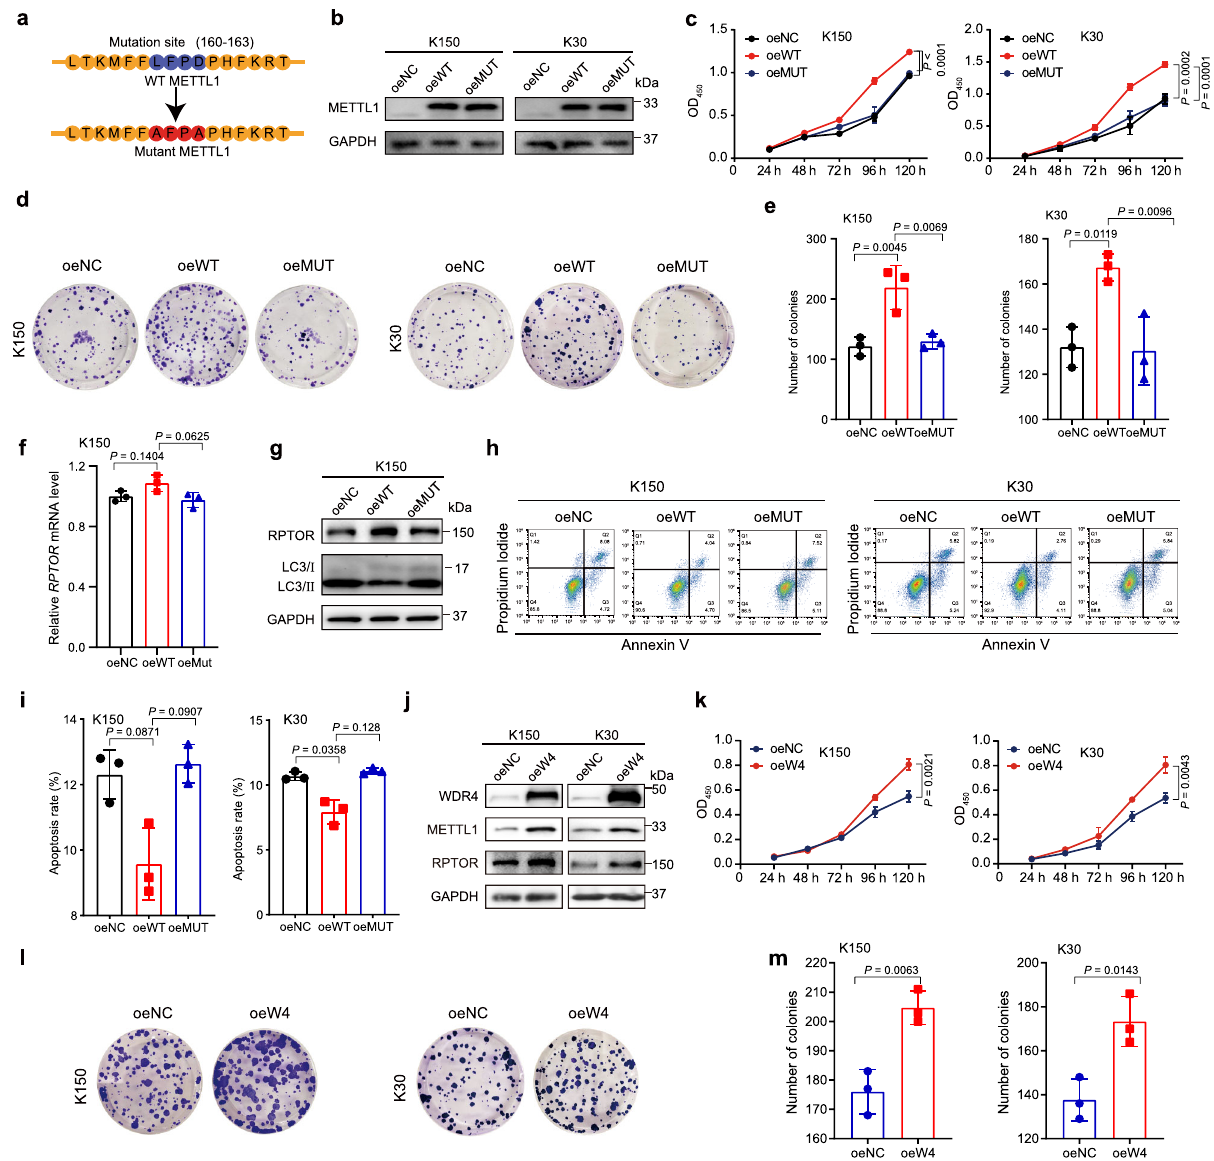
Fig. 6 Overexpression of METTL1 or WDR4 promotes ESCC progression. a The catalytic mutation site of METTL1. b Western blot con fi rmed the overexpression of wild-type METTL1 (oeWT) and catalytic inactive METTL1 (oeMUT) compared with the negative control (oeNC) in ESCC cells. c CCK8 assay of growth of oeNC, oeWT, and oeMUT ESCC cells. d , e Colony-formation assay ( d ) and the quanti fi cation analysis ( e ) of oeNC, oeWT, and oeMUT ESCC cells. f qRT-PCR assay of RPTOR mRNA level. g Western blot assay showed the indicated protein levels. h , i Apoptosis assay ( h ) and the quantitative analysis ( i ) of METTL1 overexpression and control cells. j Western blot assay showed the indicated protein levels. k CCK8 assay of growth of oeNC and oeWDR4 ESCC cells. l , m Colony-formation assay ( l ) and the quanti fi cation analysis ( m ) of oeNC and oeWDR4 ESCC cells. Data represented as mean ± SD from three independent experiments. P values are presented by one-way ANOVA with Dunnett ’ s multiple comparison test for ( c , e , f , and i ), and two-tailed unpaired Student ’ s t test for ( k and m